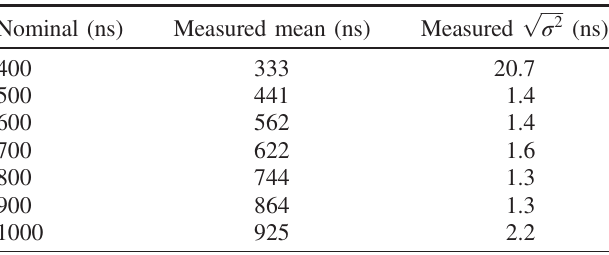
TABLE III. Analysis of the observed electron bunch length distributions (see Fig. 10).